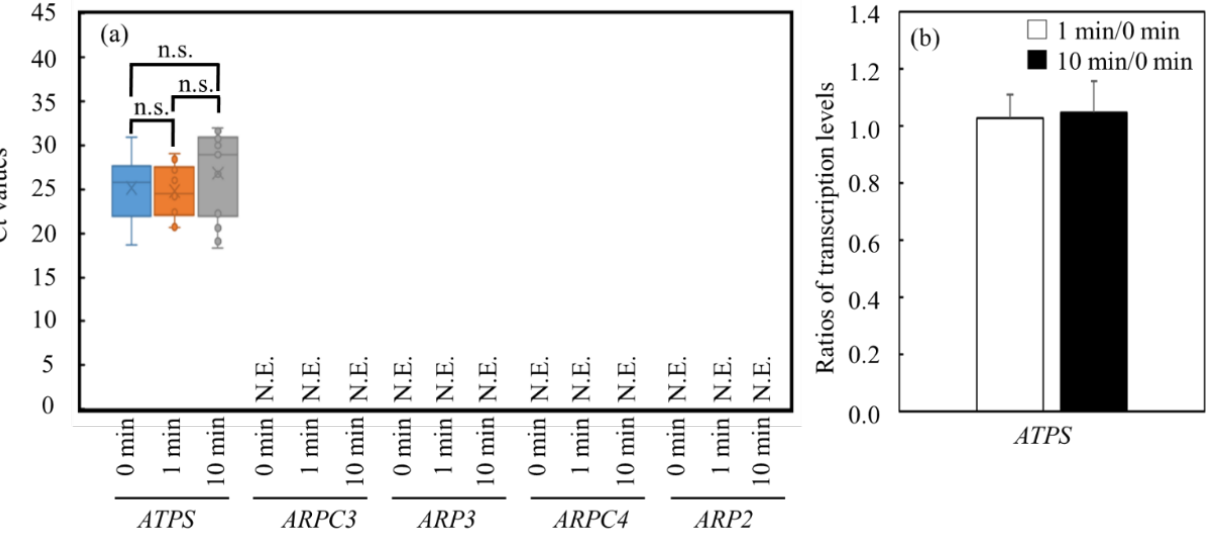
Figure 4. Ratios of transcription levels of estimated housekeeping genes in C. reinhardtii C-9: NIES- 2235 after UV-C irradiation. ( a ) Boxplot representation of raw Ct values obtained from amplification curves (n = 3). Lower and upper boundaries of the box indicate the 25th and the 75th percentile, the thin line within the box marks the median. The Ct values were evaluated at 0 min, 1 min and 10 min of UV-C irradiation. ( b ) Ratios of transcription levels of nominated ATPS before/after 10 min UV-C irradiation were evaluated with quantitative PCR. Error bars indicate the SD of three replicate experiments (n = 3). Not evaluated was abbreviated as N.E. Housekeeping genes, ATPS : ATPase beta chain of ATP synthase gene; ARPC3 : actin-related protein Arp2/3 complex, subunit ARPC3 gene; ARP3 : actin-related protein Arp2/3 complex, subunit Arp3 gene; ARPC4 : actin-related protein Arp2/3 complex, subunit ARPC4 gene; ARP2 : actin-related protein Arp2/3 complex, subunit Arp2 gene.